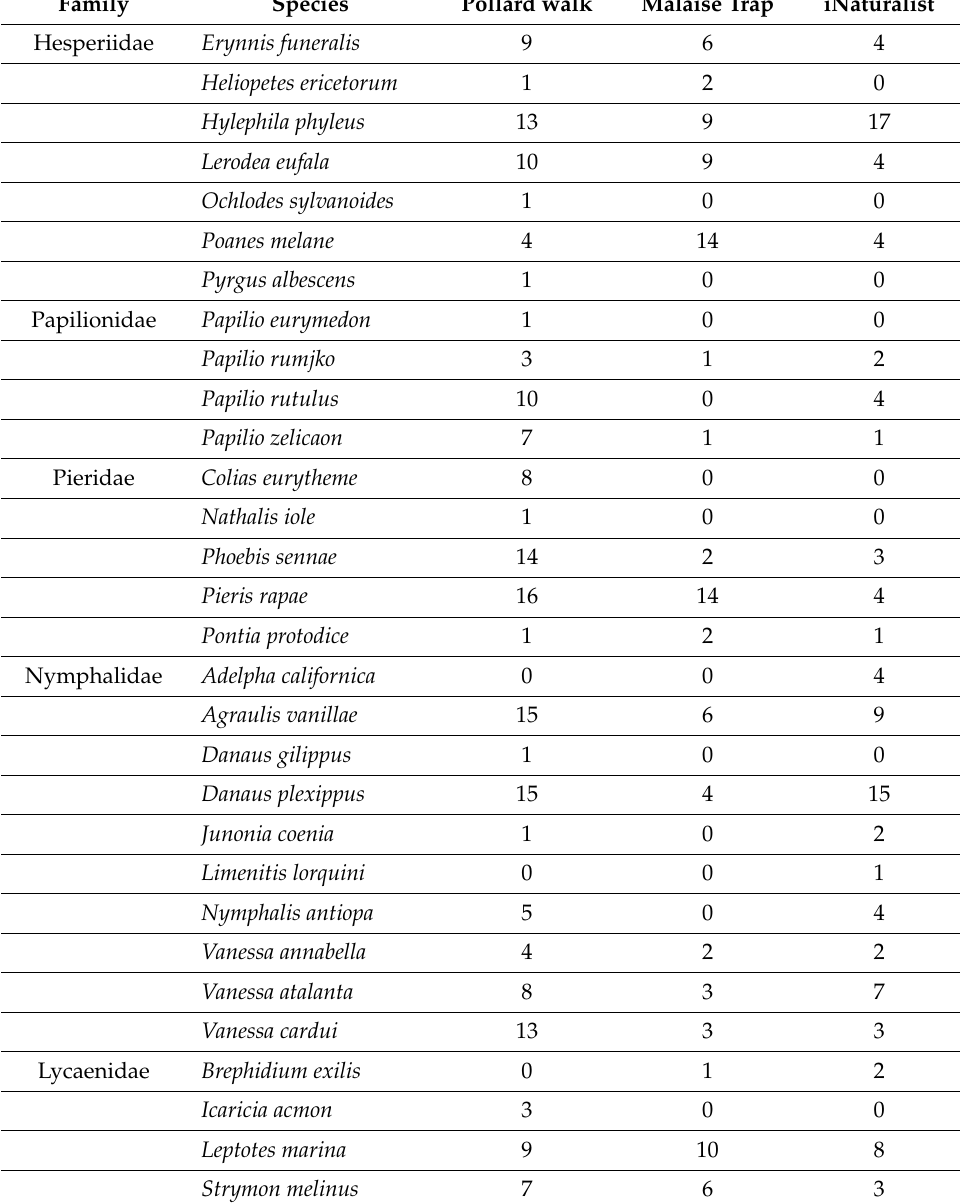
Table 1. Species observed in three data sources: ButterflySCAN Pollard walks, BioSCAN Malaise traps, and iNaturalist observations. For Pollard walks and Malaise traps, the number is the total number of sites where the species was observed; for iNaturalist data, the number is the total number of observations of species within the temporal and geographical limits of SCAN surveys (see Section 2: